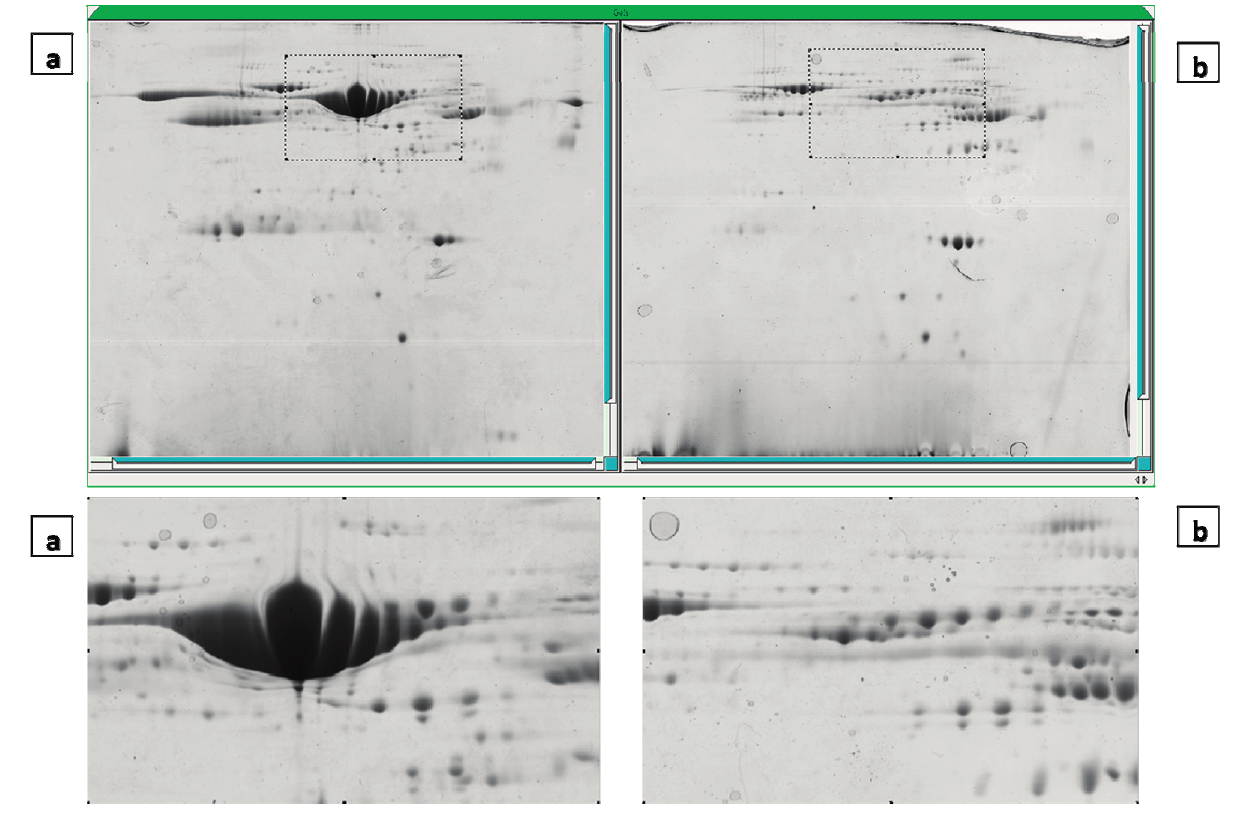
Figure 1. Two-dimensional gel electrophoresis map of crude ( a ) and albumin/IgG-depleted follicular fluid ( b ) (Coomassie blue staining).